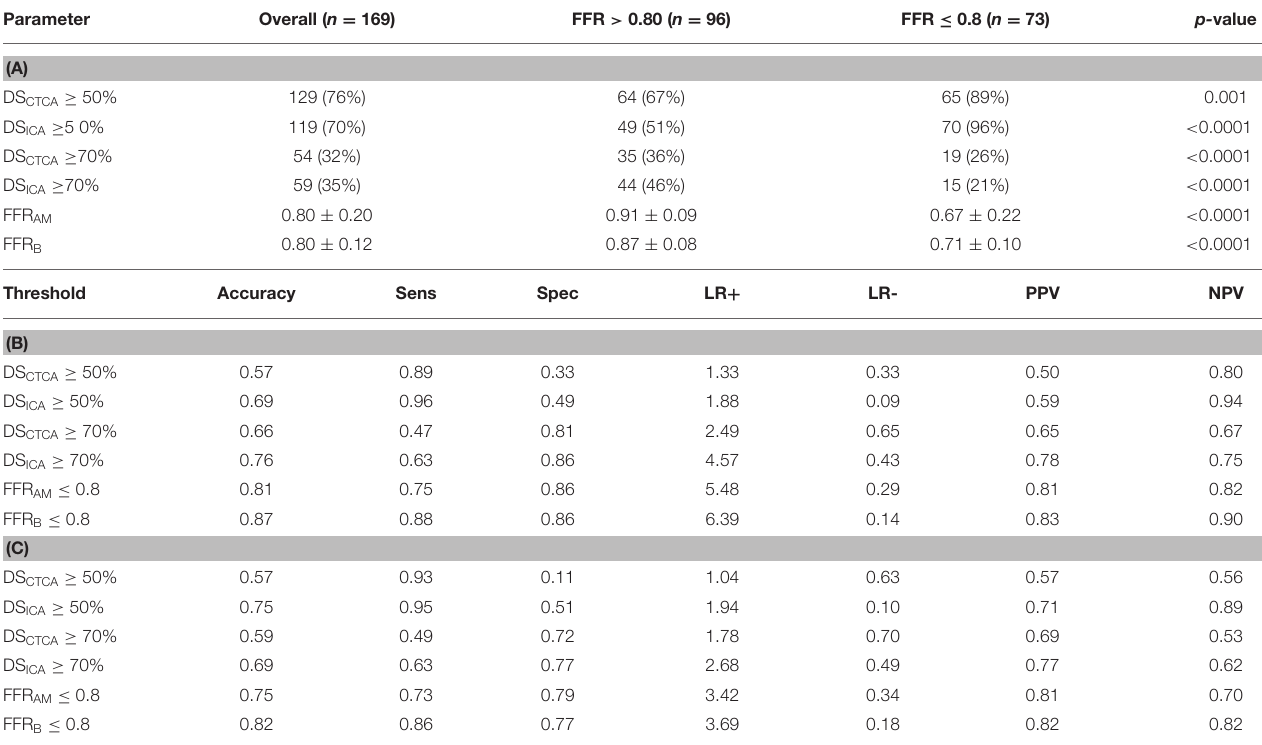
TABLE 3 | (A) Diameter stenoses (DS CTCA and DS ICA ) and non-invasive FFR (FFR AM and FFR B ) in study groups (FFR > 0.8 and FFR ≤ 0.8; (B) Comparison of diagnostic performance of different parameters for predicting myocardial ischemia at per-vessel level; (C) Comparison of diagnostic performance of different parameters for predicting myocardial ischemia at per-patient